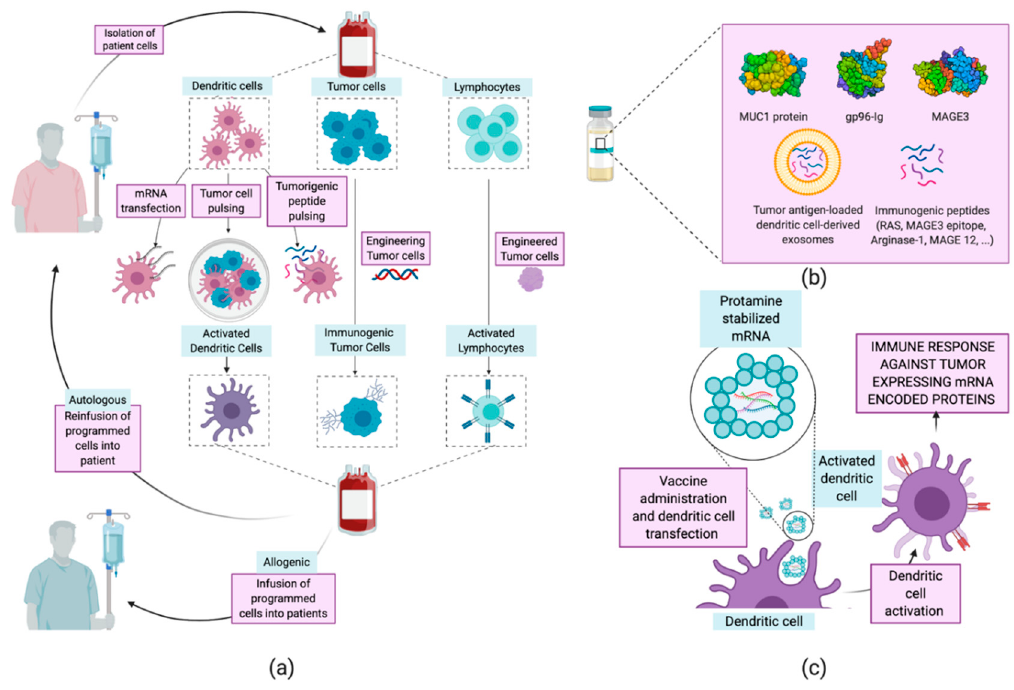
Figure 7. Current strategies for NSCLC cancer vaccines. ( a ) Whole-cell cancer vaccines. Dendritic, tumor, or lymphocyte cells are removed from the patient and modified ex vivo to increase their immune/immunogenic activity. Finally, they are delivered back to the donor patient—autologous therapy—or other patients—allogeneic therapy. ( b ) Protein- and peptide-based vaccines. Systematic administration of proteins or peptides previously identified as tumor antigens. ( c ) mRNA vaccines (RNActive ® ). Administration of five mRNAs, recognized for their immunogenic nature, stabilized by complexing with cationic proteins for the easy transfection of dendritic cells that will activate the immune response, entering the priming phase of T cells.